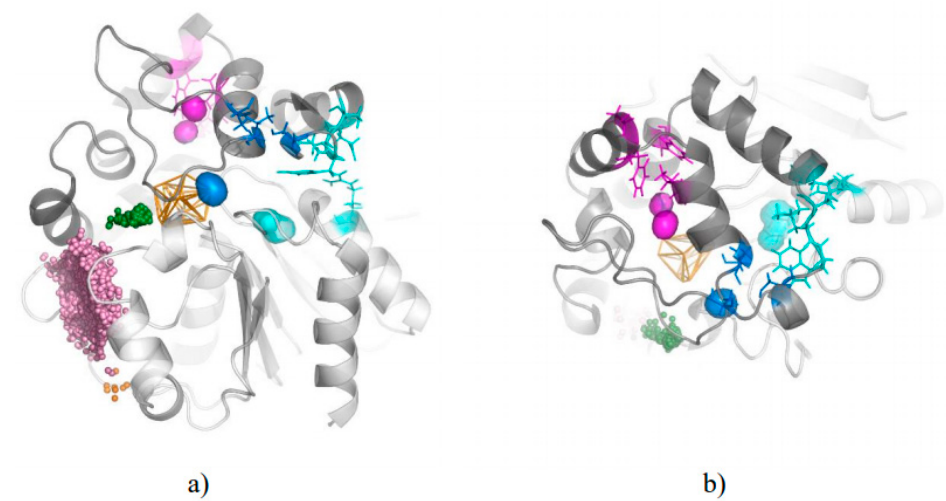
Figure 4. Localisation of outliers entry/exit regions. The protein side view ( a ) and top view ( b ) are shown. The core domain is shown as a light-grey cartoon, the cap domain as a dark-grey cartoon, water molecules inlets are shown as pink, green, and orange spheres for TM1, TC/M, and TM2 clusters, respectively. The cavities (interior surfaces) and residues making outliers entry/exit regions (lines) are shown in blue, cyan and magenta for I, II, and III, respectively.